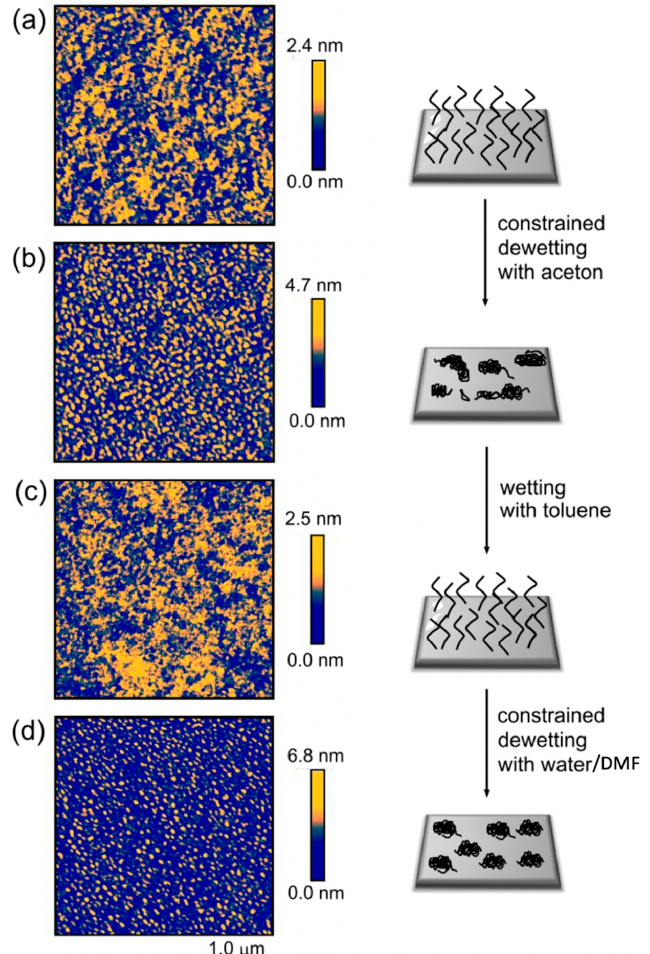
Figure 3. Constrained dewetting of surface-grafted linear polystyrene ( M n = 64 kg / mol, Σ = 3.6) with two different solvents. ( a ) Homogeneous polymer layer mediated by toluene, ( b ) nanostructure of polystyrene formed by immersion in acetone, ( c ) homogenous polymer layer mediated by toluene, ( d ) nanostructure of polystyrene formed by dewetting with dimethylformamide and water.